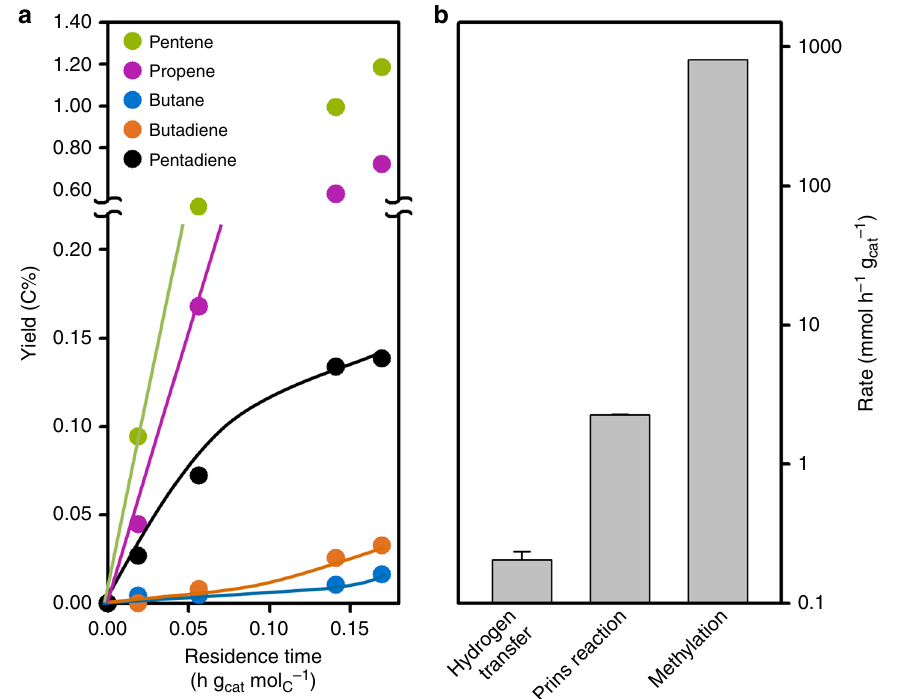
Fig. 6 Reaction of 1-butene with HCHO over H-ZSM-5. a Product yield as a function of residence time. Reaction condition: 1-butene 45 mbar, HCHO 0.32 mbar, H 2 O 22.5 mbar, 475 °C. b Reaction rates obtained for hydrogen transfer, Prins reaction (initial rates of formation of butane and pentadiene respectively under reaction conditions shown in a and methylation (represented by the DME/MeOH conversion rate at ~40% conversion shown in Fig. 1) on H-ZSM-5. Error bar represents the standard error of the reactions rates